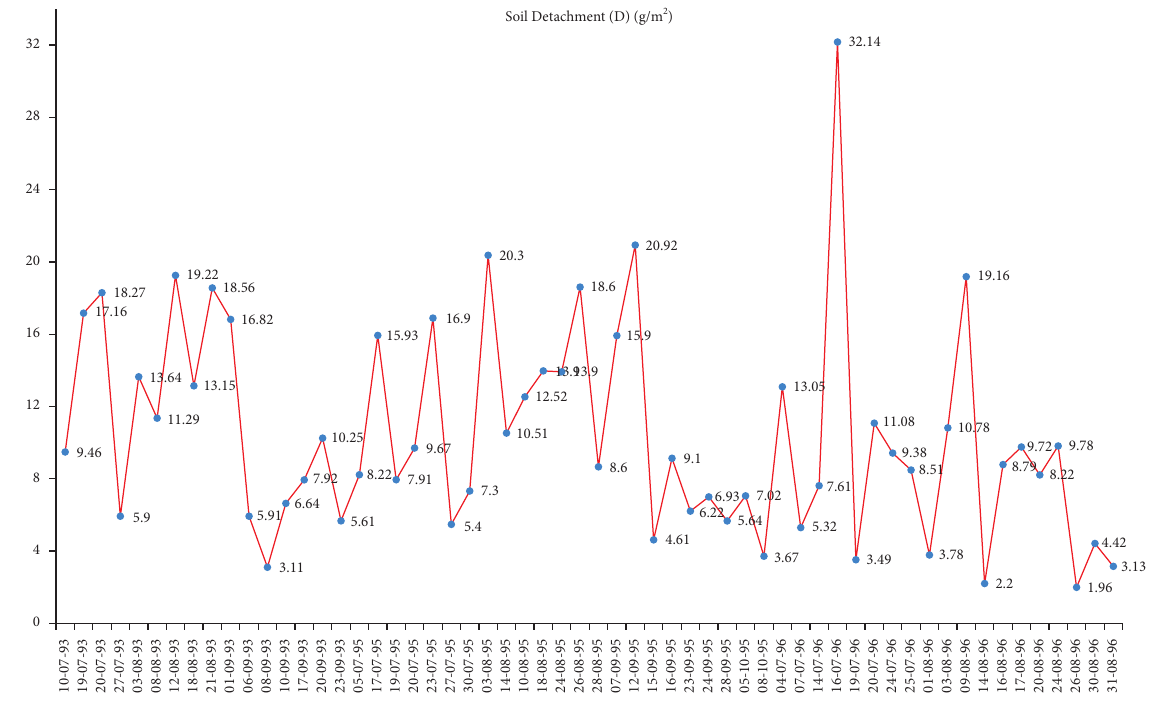
Figure 7: Soil detachment with the selected dates of observation.